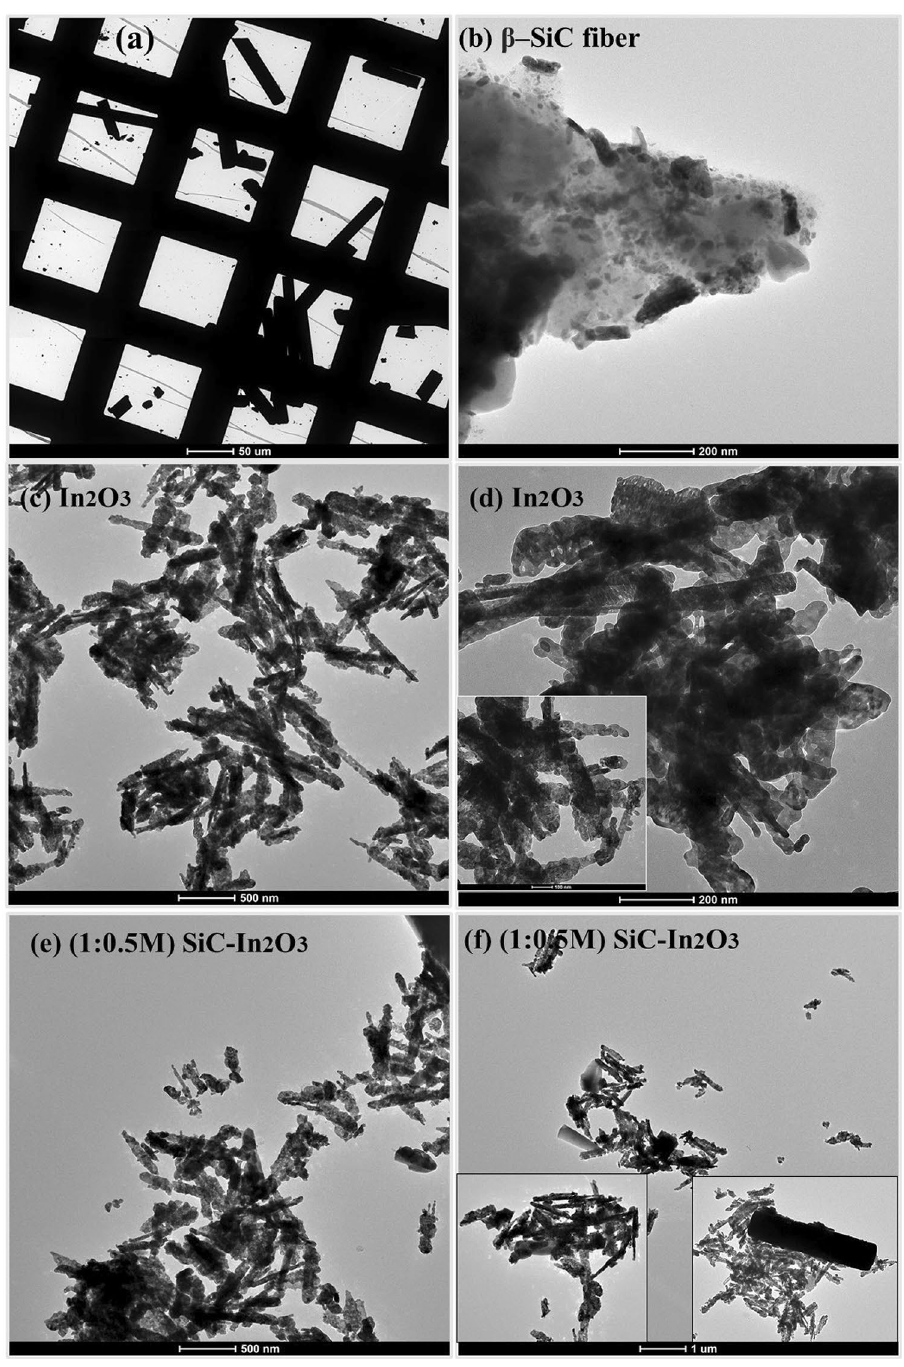
Figure 5. TEM images of the ( a , b ) pure β-SiC fiber, ( c , d ) In 2 O 3 and ( e , f ) β-SiC-In 2 O 3 (1:0.5 M) nanocomposite (thermal annealing at 400